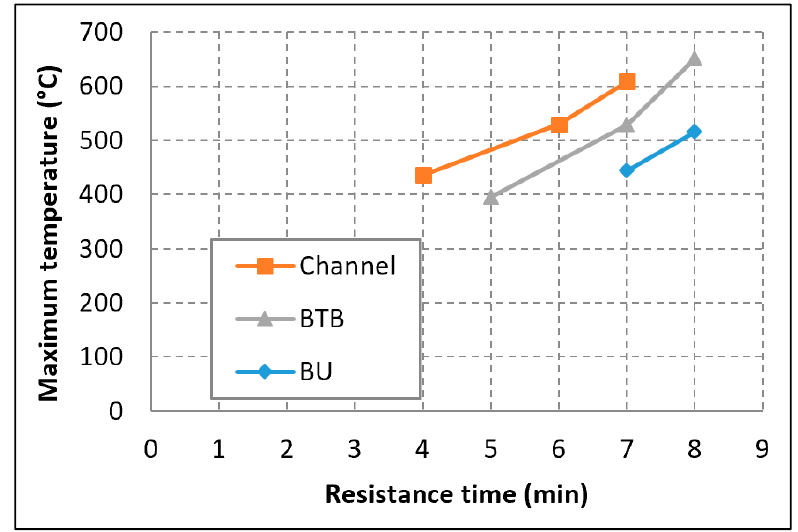
Figure 15. Effect of steel section type on maximum temperature and resistance time.